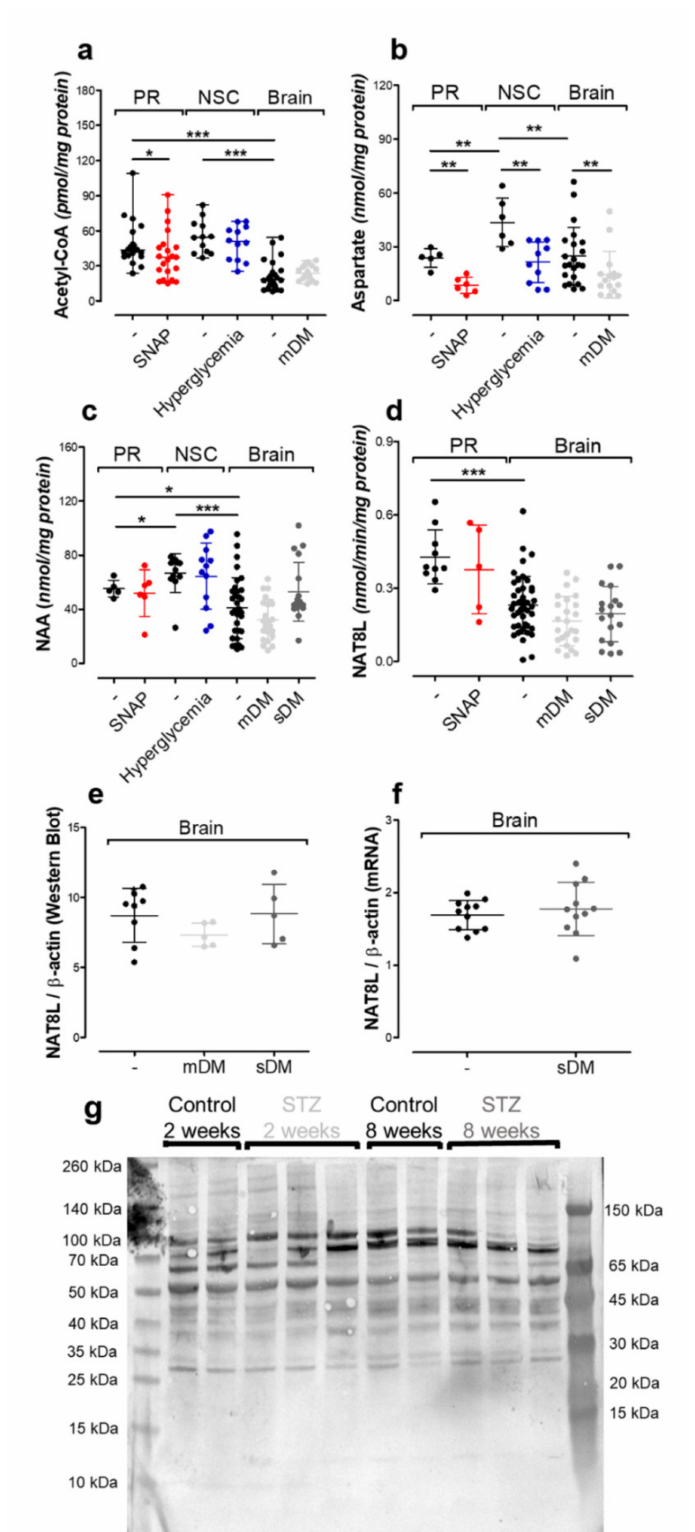
Figure 3. The impact of toxic factors on the NAA network measured in primary neurons (PR), neural stem cells (NSC) and brain tissue (Brain): ( a ) acetyl-CoA level; ( b ) aspartate level; ( c ) N -acetylaspartate level; ( d ) aspartate N -acetyltransferase (NAT8L) activity; ( e ) NAT8L protein level (Western blot); ( f ) Nat8l mRNA level (real-time RT-qPCR); ( g ) representative WB (Western Blot) membrane image for NAT8L protein. Data are means ± SD from 5–22 observations per group. Significantly di ff erent from the control: * ( p –value < 0.05), ** ( p –value < 0.01), *** ( p –value <